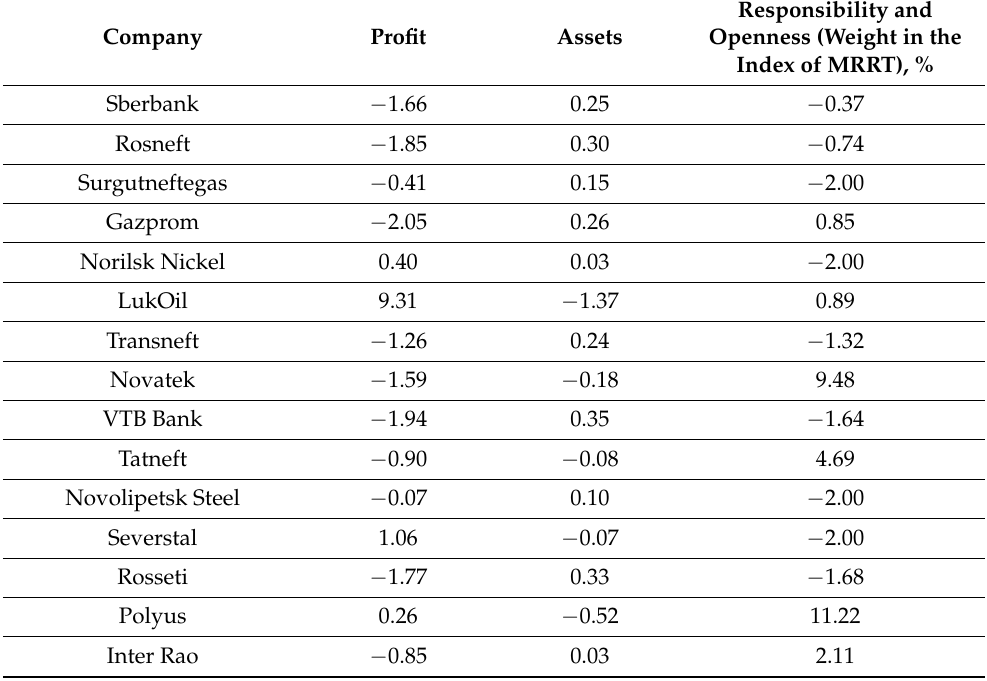
Table A6. Chi-square points for three